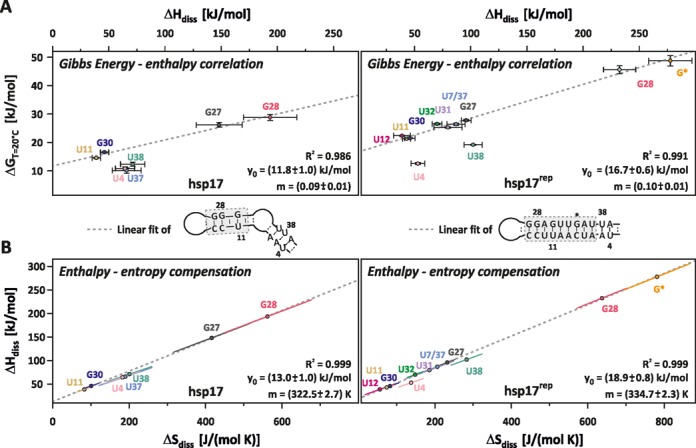
(A) Gibbs energy–enthalpy correlation and (B) enthalpy–entropy compensation in hsp17 (left) and hsp17rep (right). Correlations of highlighted nucleobases (dashed box) were fitted according to the linear relationship \documentclass[12pt]{minimal}
\usepackage{amsmath}
\usepackage{wasysym}
\usepackage{amsfonts}
\usepackage{amssymb}
\usepackage{amsbsy}
\usepackage{upgreek}
\usepackage{mathrsfs}
\setlength{\oddsidemargin}{-69pt}
\begin{document}
}{}$y\left( x \right) = m*x + y_0$\end{document} (dashed line). Error bars in (A) represent the Monte Carlo errors, ellipses in (B) are the confidence ellipses at the one σ-level, which describe the distribution of the ΔH and ΔS pairs obtained from the Monte Carlo simulation. Errors for the linear fit represent standard deviations obtained from linear regression.